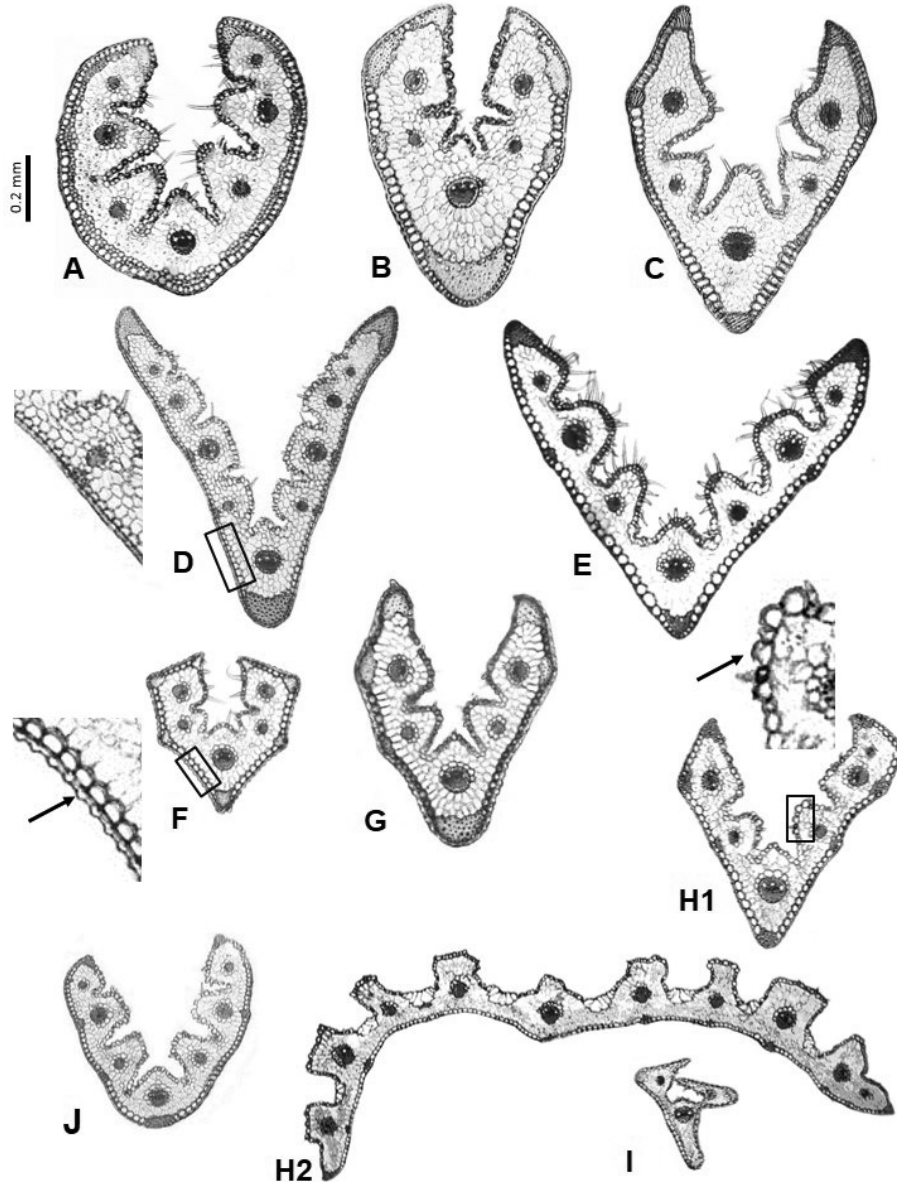
Figure 6. Leaf cross-sections of Iberian species of the Festuca sect. Aulaxyper from lineage 2: A F. junci- folia B F. rubra subsp. pruinosa C F. rivularis D F. rothmaleri (in detail abaxial surface not scalloped) E F. nevadensis F F. iberica (in detail scalloped abaxial surface) G F. nigrescens H F. heterophylla subsp. braun- blanquetii (H1 innovation leaf, in detail inflated adaxial epidermal cells; H2 cauline leaf) I F. heterophylla subsp. heterophylla (innovation leaf); and from lineage 3: J F. pyrenaica. Scale bars: 0.2